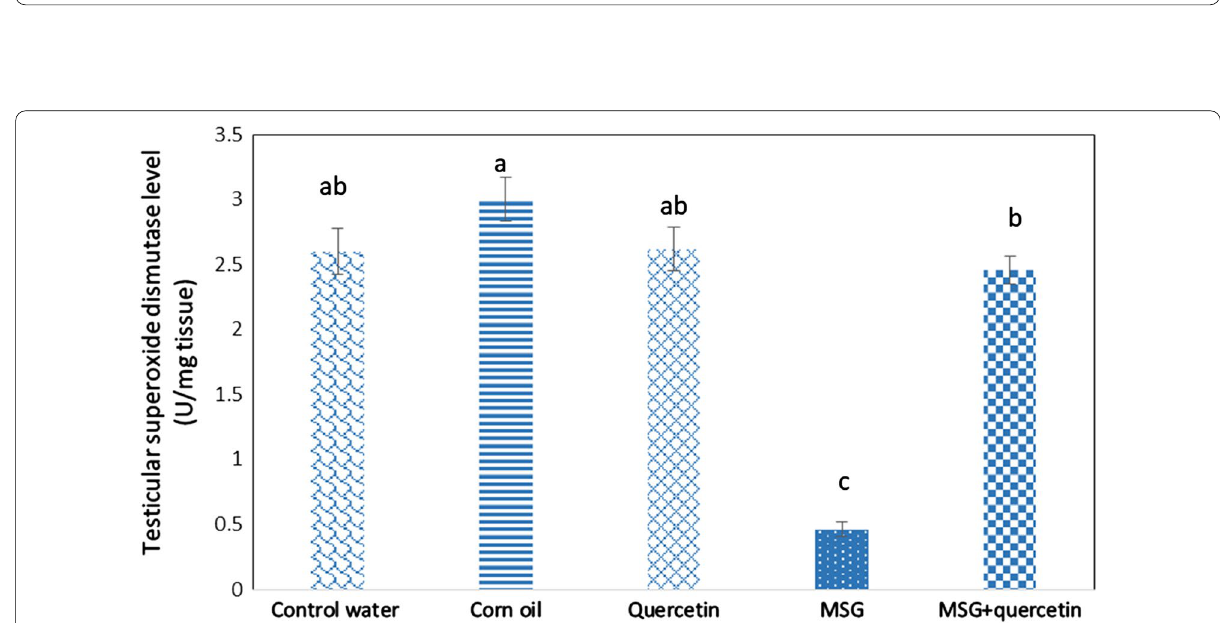
Fig. 4 Effect of quercetin on the level of superoxide dismutase (unit per milligram tissue) in testis homogenate of MSG‑intoxicated male rats for 30 days. The number of samples in each group is six.Values were expressed as mean symbol(s) are significantly different at P <